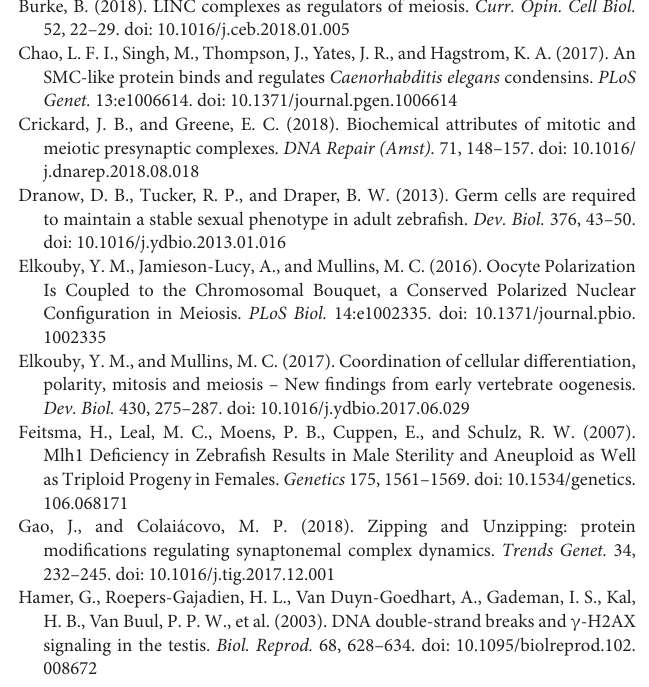
Supplementary Figure 1 | Conservation of key motifs in vertebrate Smc1b proteins. (A) Graphical representation of zebrafish Smc1b protein. Numbers inside boxes represent amino acid position in the corresponding domain. (B) Percentage of identical amino acid residues between zebrafish (z) and either human (h) or mouse (m) Smc1b proteins. (C–E) Protein sequence alignments of the N-terminal ATP binding domain (C) , flexible hinge domain (D) , and C-terminal ATP binding domain (E) . The conserved motifs are highlighted in green. The consensus motif sequences are Walker A: GxxGxGK (S/T), ABC transporter signature motif: LSGG(E/Q) (K/R), Walker B: hhhhDE, where x is any of 20 amino acid and h is any hydrophobic